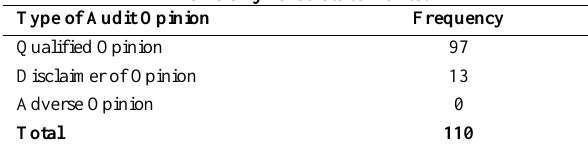
Table 1. Frequency of audit opinions of firms